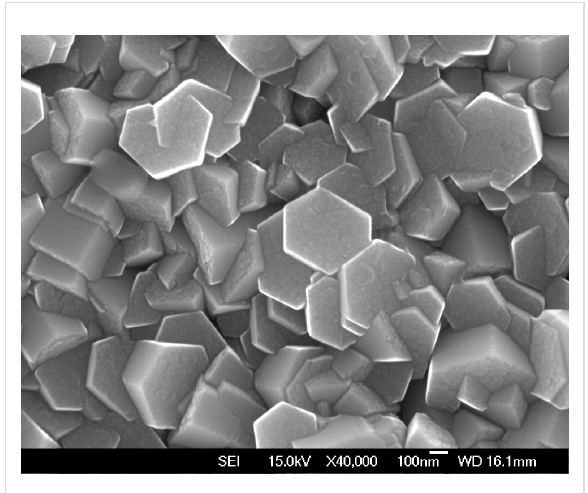
Figure 6: SEM top morphology of ZnO nanorod arrays grown on a ZnO-seeded ITO substrate at 60 °C for 24 h.